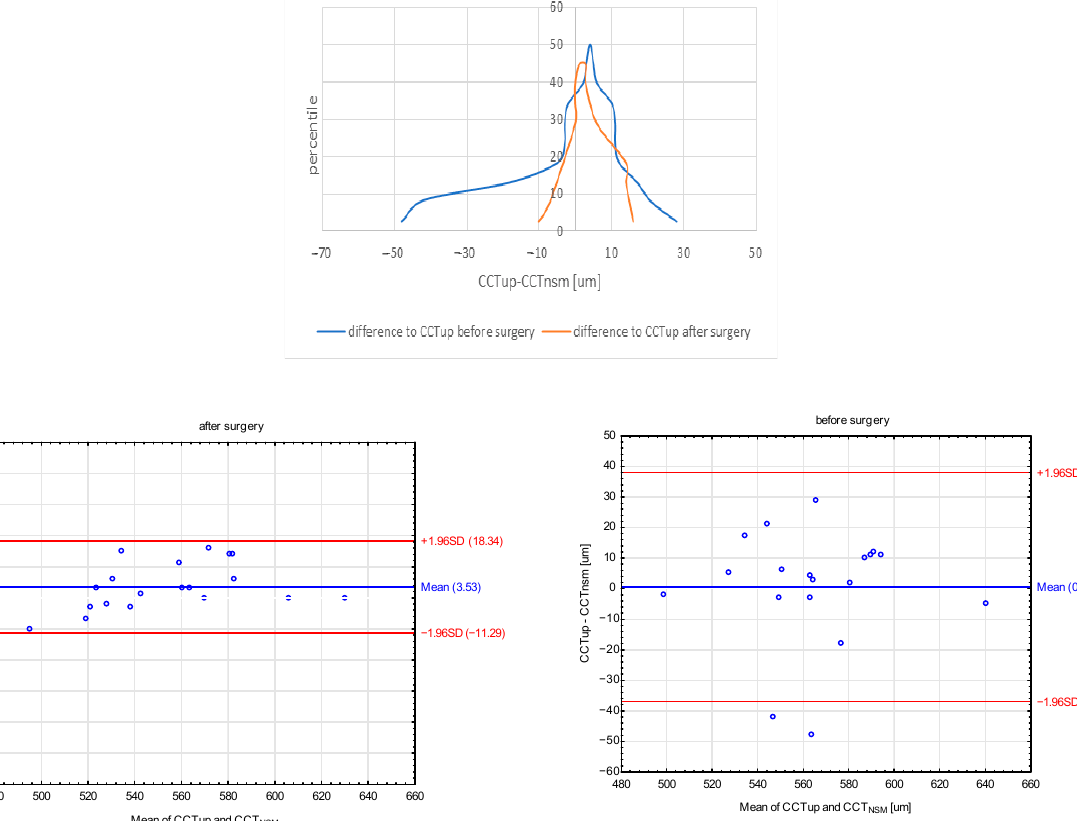
Figure 1. Mountain plots and Bland–Altman plots showed the distribution of the differences between CCT UP and CCT NSM before and after surgery. CCT UP , ultrasonic pachymetry; CCT NSM , non-contact specular microscopy.